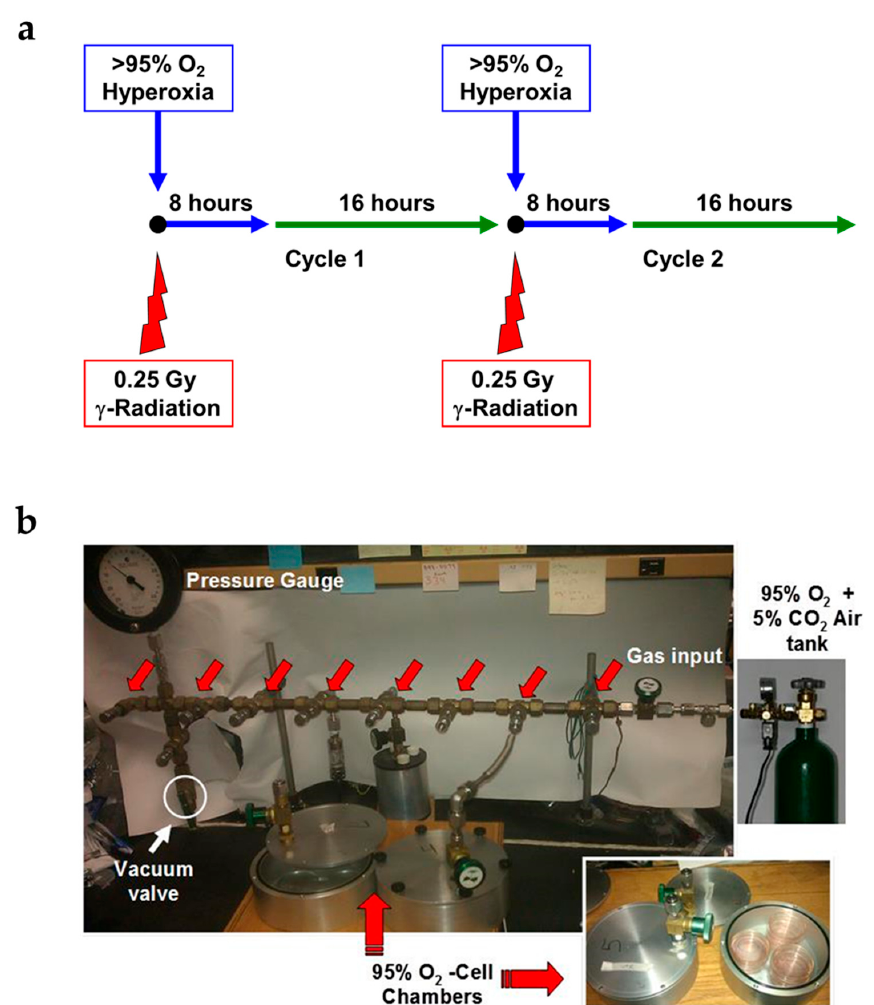
Figure 1. Experimental plan of in vitro cell exposure. ( a ) Non-tumorigenic murine alveolar type II epithelial cells (C10) were exposed to 100% O 2 for 8 h only (O 2 ), 0.25 Gy ionizing γ -radiation (IR) only, or a double-hit combination of both challenges (O 2 + IR) followed by 16 h of normoxia (21% partial pressure of oxygen (pO 2 )) (1 cycle). This was repeated for 2 cycles and cells were harvested at the end of each 24 h cycle: 1 and 2 cycles of exposure corresponding to 24 and 48 h, respectively; ( b ) Images displaying the experimental setup of in vitro cell exposure. Pictured are the chambers holding the 6 cm cell culture Petri dishes and the gas manifold allowing for O 2 exposure.